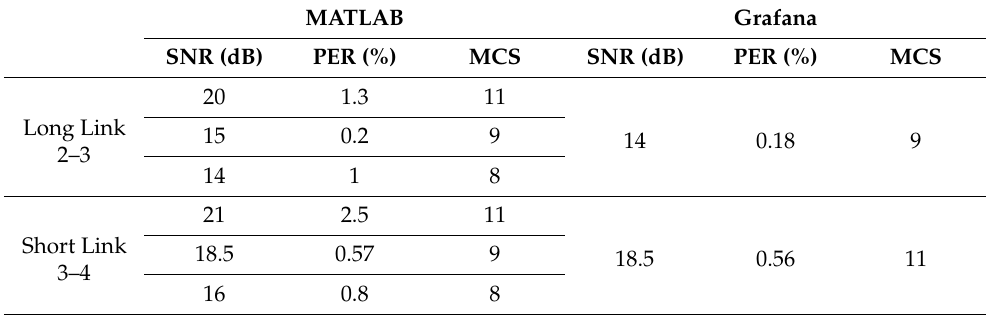
Table 3. Results Comparison.